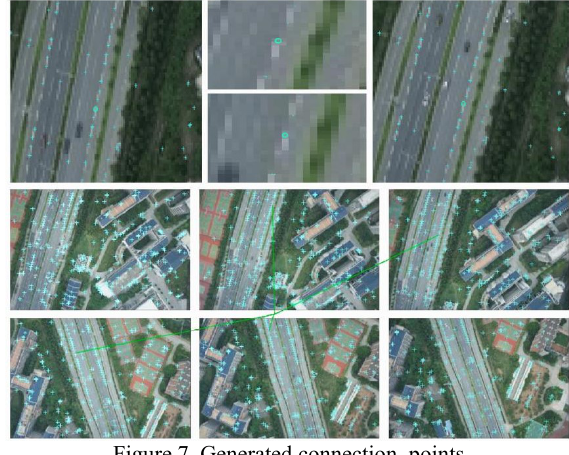
Figure 7. Generated connection points